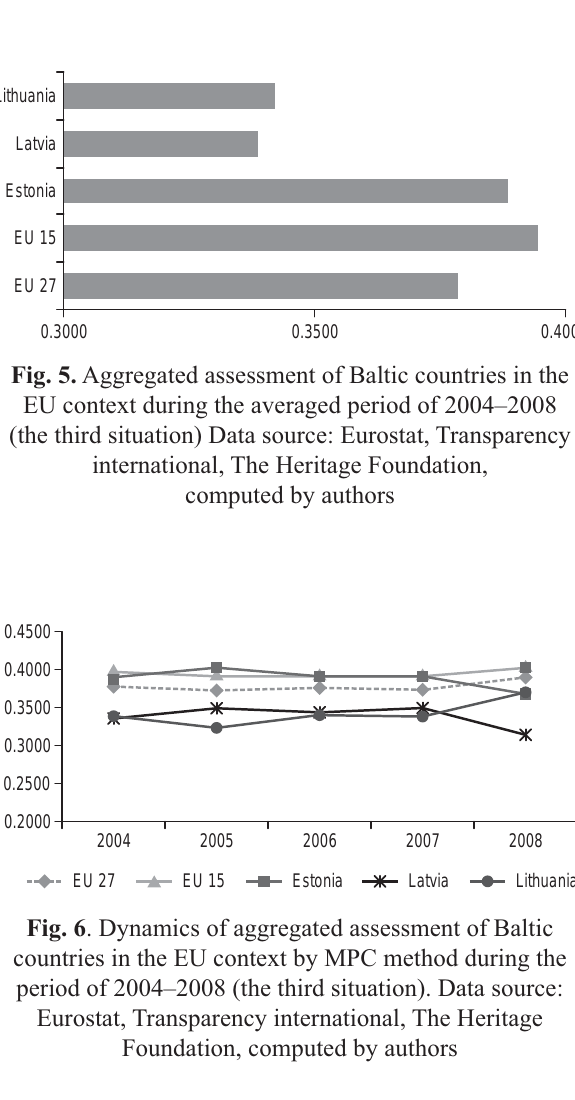
Table 2. Ranking of Baltic countries according to multi- criteria evaluation variants